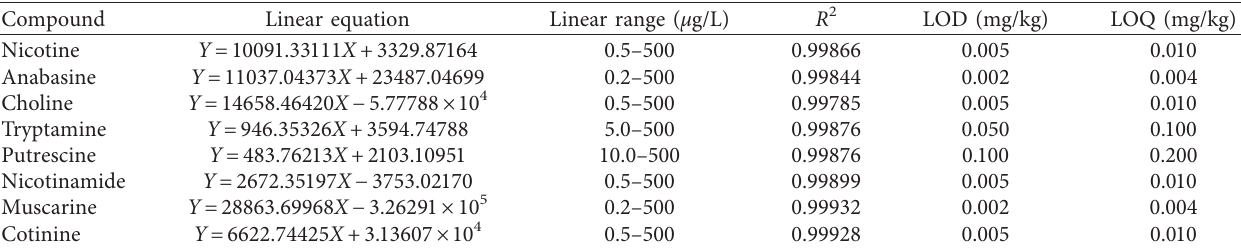
Table 2: Linearity, LODs, and LOQs of the 8 endogenous alkaloids.